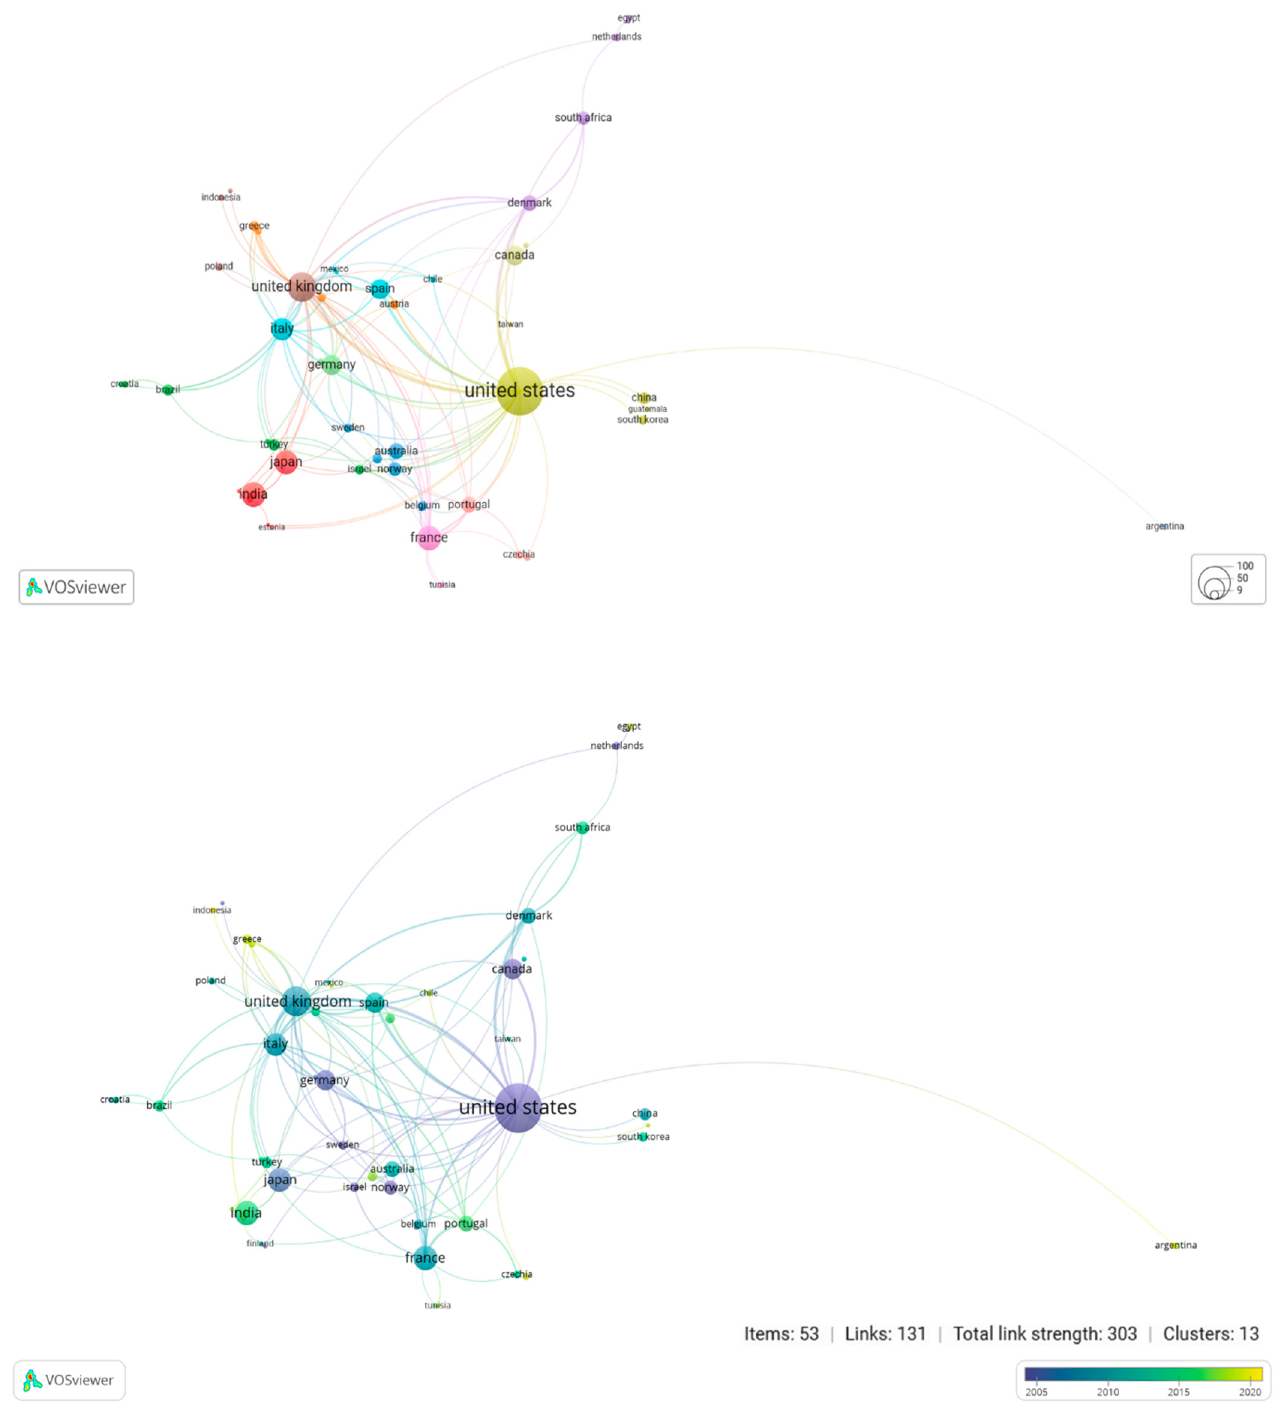
Figure 3. The upper image shows the network visualization co-authorship of institutional countries, and the lower image replicated the data per year. All publications were included regardless of co-authorship count—23 clusters were identified. Bibliometric mapping is interactable at https://app.vosviewer.com/?json=https://drive.google.com/uc?id=1JQISmtge-GFubEc6qieJjb4iCyeymqrV (accessed on 15 January 2023).